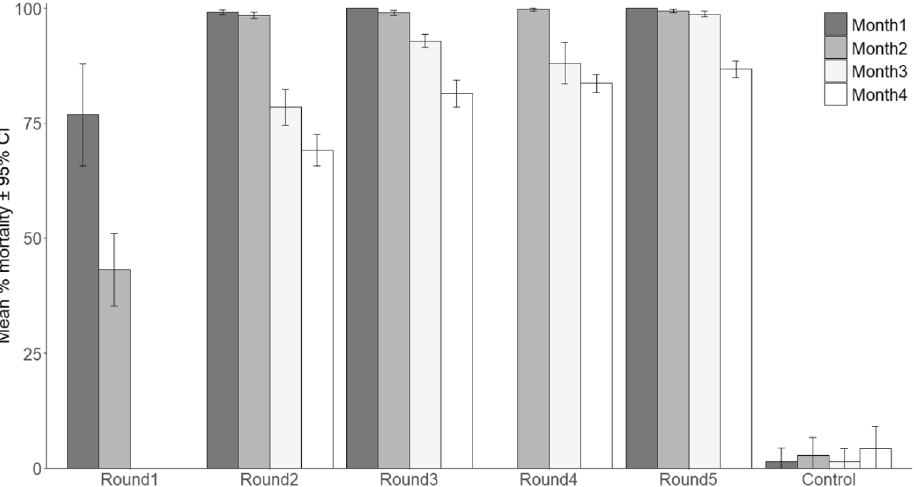
Figure 2. Average mortality of pyrethroid resistant An. gambiae mosquitoes exposed to beta-cyfluthrin treated inserts retrieved from trial villages. Bars represent average mortality for the 20 EaveTubes villages. Round indicates insert re-treatment cycle performed during the Eave Tubes trial; Round1 occurred between Mar 2017–May 2017, Round2: Jul 2017–Aug 2017; Round3: Dec 2017–Jan 2018; Round4: Apr 2018–May 2018 and Round5: Oct 2018–Nov 2018. Error bars indicate 95% confidence